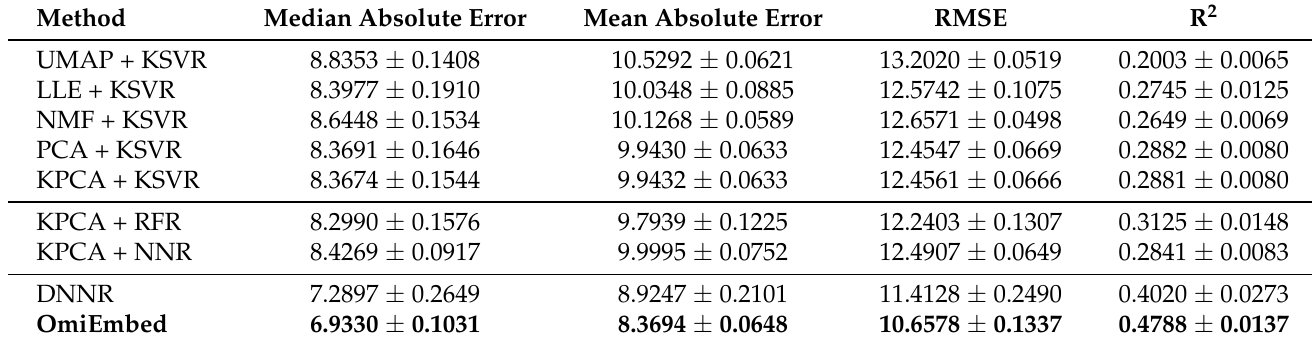
Table 6. The age prediction performance of OmiEmbed and eight other methods on the GDC dataset. For median absolute error, mean absolute error and RMSE, lower values mean better regression performance. For R 2 score, higher values mean better regression